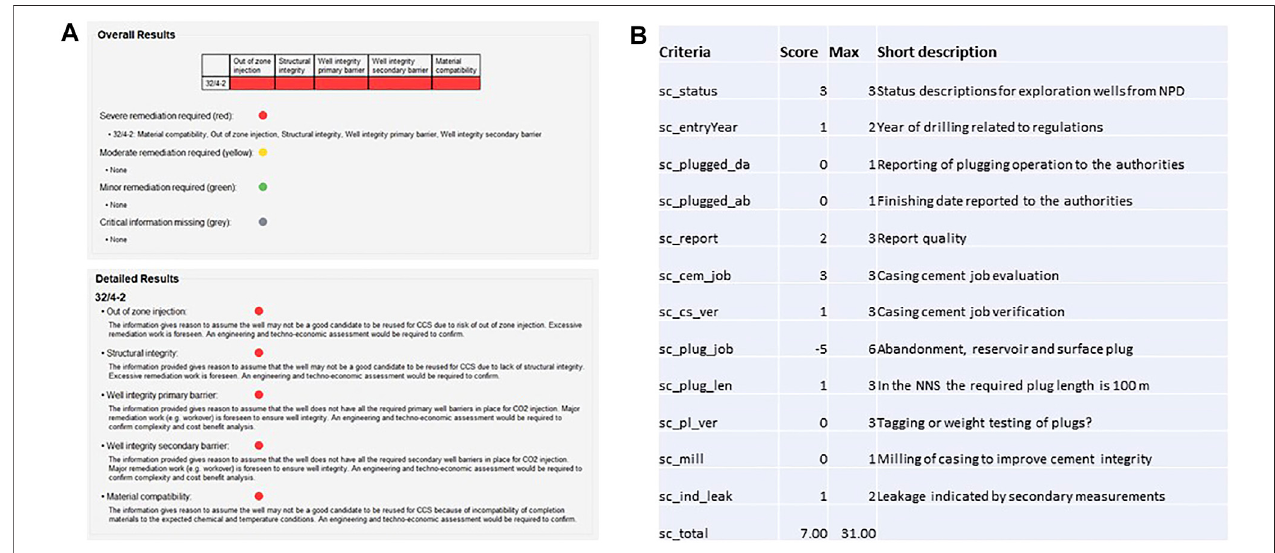
FIGURE 5 | Results of 32/4-1 T2 well screening and evaluation. (A) The screenshots from the REX-CO2 tool (Pawar and van der Valk, 2020) show the fi nal evaluationandarecommendationforsevereremediation. (B) ThescreeningmethodfromEmmelandDupuy(2021)resultsina fi nalscoreofseven(sc_total),suggesting a more detailed inspection of data from well 31/2-4.